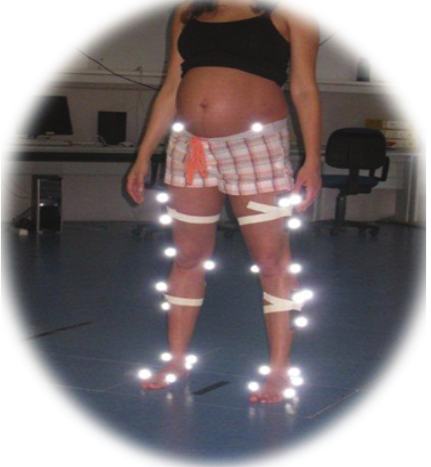
Figure 1: Spherical reflective markers placed with double-sided adhesive tape on the skin, in both sides of the lower body of a pregnant